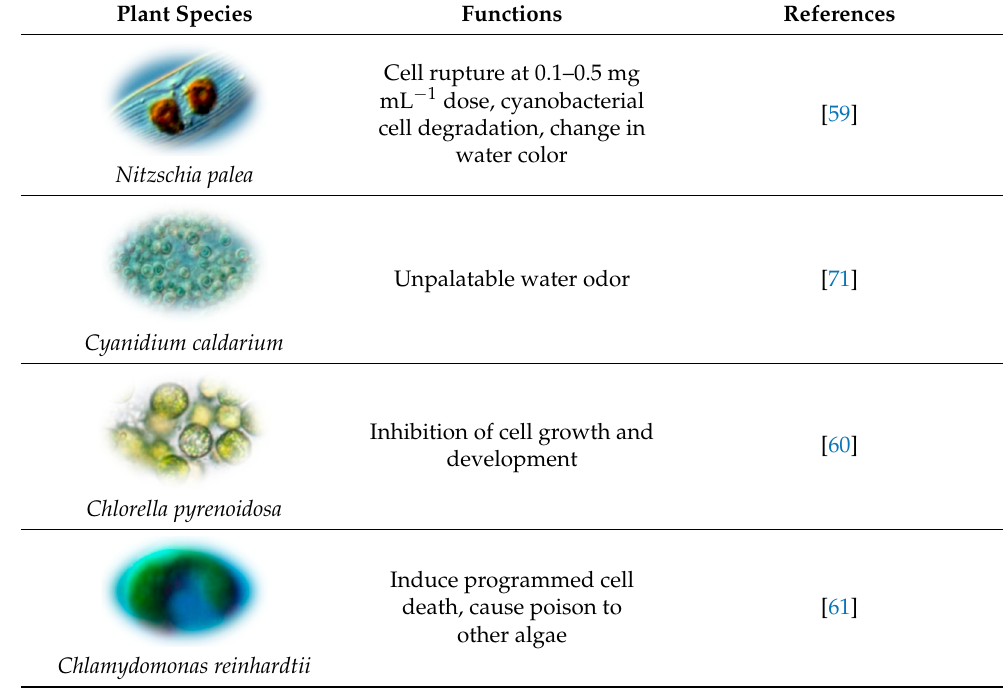
Table 1. Various functions of β CC in Plants. Plant Species